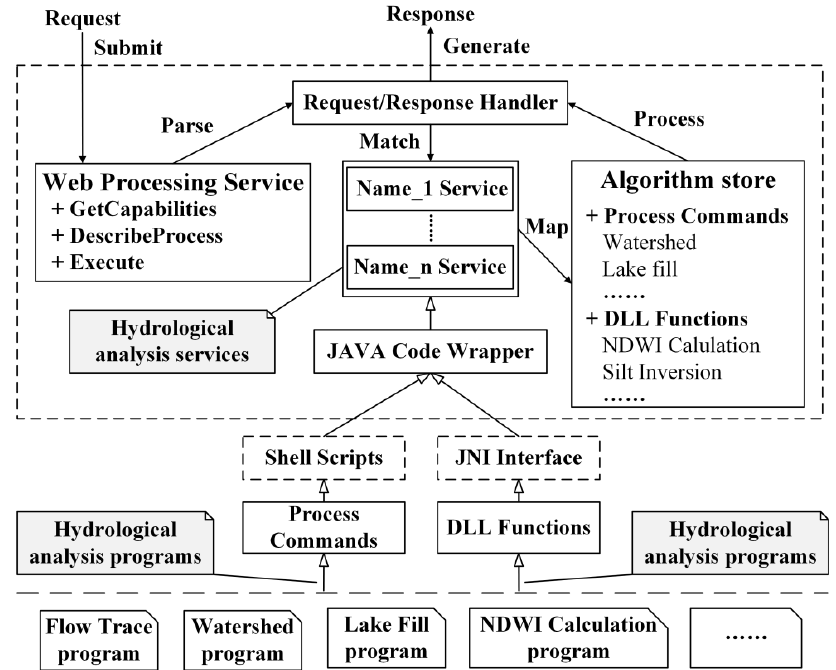
Figure 4. A wrapper for hydrological analysis programs.